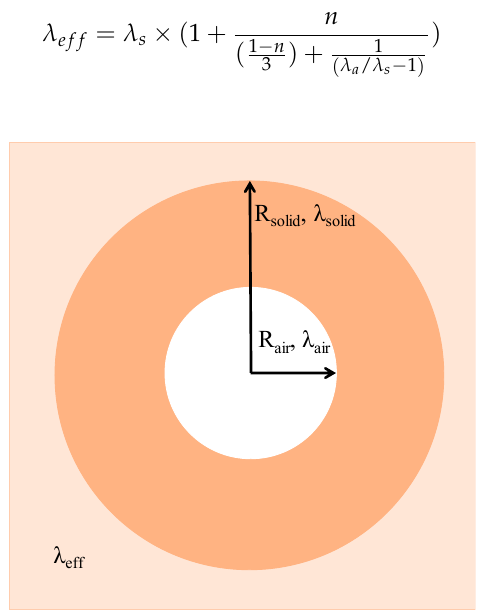
Figure 6. Thermal conductivity measurement of S ‐ BP composite.